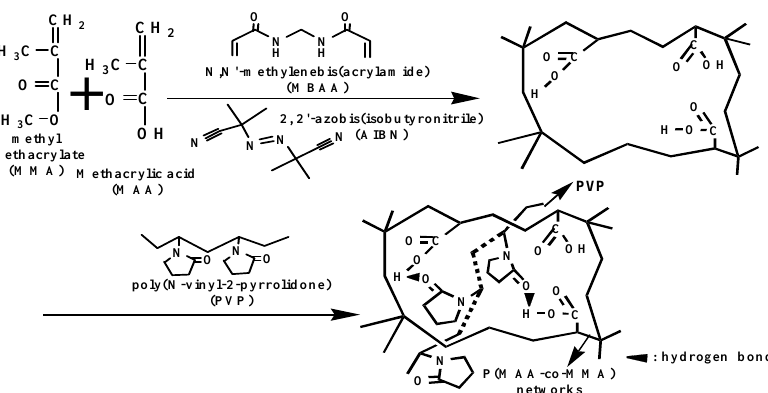
Figure 1. FTIR spectra of PVP and P(MAA-co-MMA)/PVP complexes